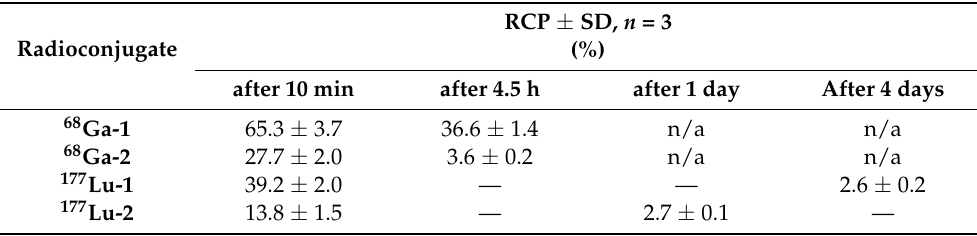
Figure 8. RP-HPLC radiochromatograms illustrating the results of the stability tests of the 68 Ga-1 and 177 Lu-1 ( left , System 3) and 68 Ga-2 , 177 Lu-2 ( right , System 4) radioconjugates in human serum recorded after different time intervals. Table 5. Statistical data of the 68 Ga-1 , 177 Lu-1 , 68 Ga-2 , and 177 Lu-2 radioconjugates radiochemical purity corresponding to the radiochromatograms presented in Figure 8.